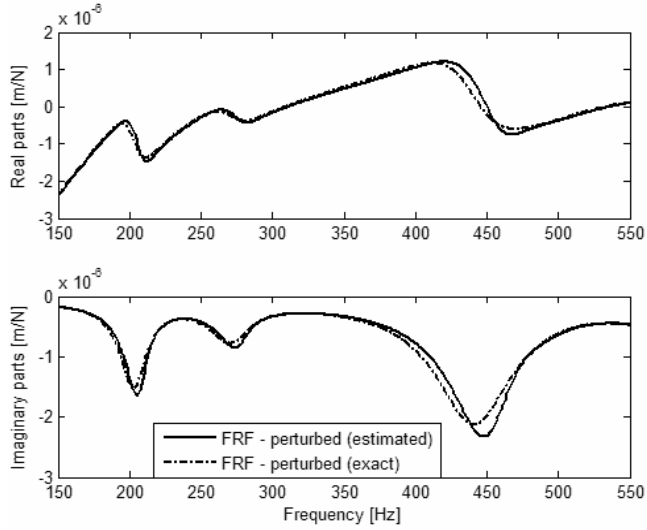
Fig. 11. Exact and first-order approximation of the FRF H II ( ω,T,p ) of the perturbed system by variation of